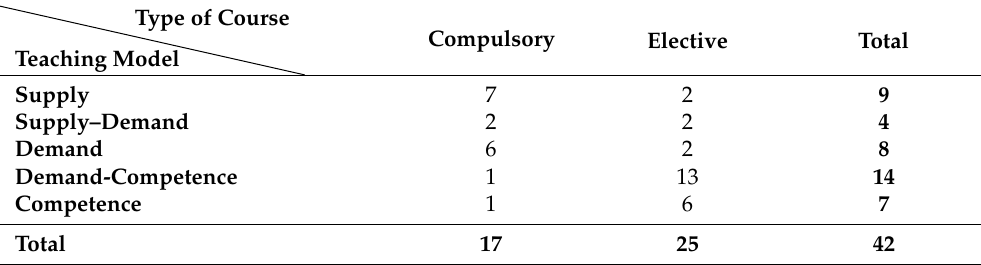
Table 6. Distribution of courses according to types of courses and teaching models.